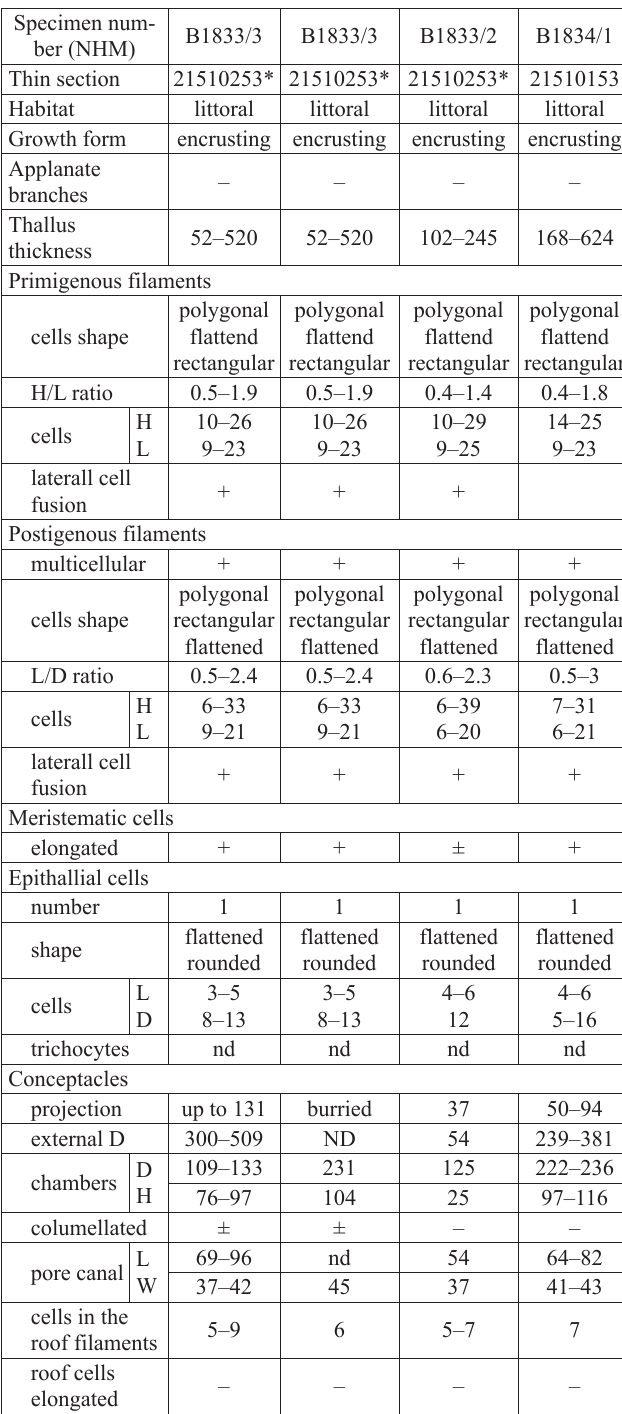
Table 6. Comparative table of selected Hydrolithon sp. 1 specimens from Carpatian Foredeep. * marks gametangial or carpogonial-carpo- sporangial plants. Abbreviations: D, diameter; H, height; L, length; W, wide; nd, no data; “+” presence and “–” absence of character; “±” intermediate. All measurements in μ